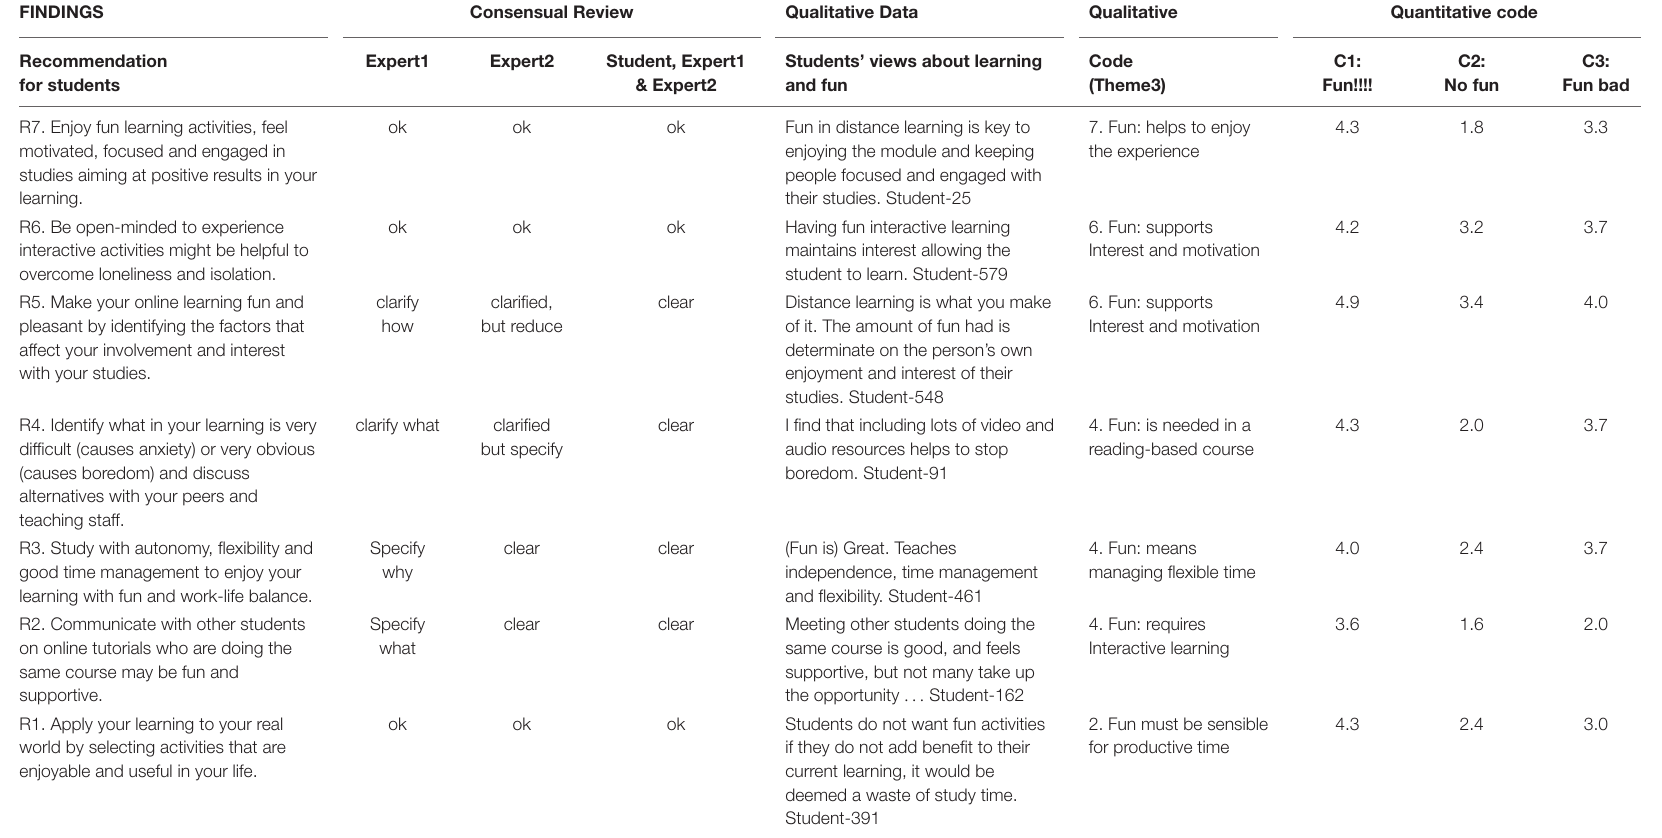
TABLE 3 | Recommendations about Online Learning and Fun for students supported by mixed methods. FINDINGS Consensual Review Recommendation for